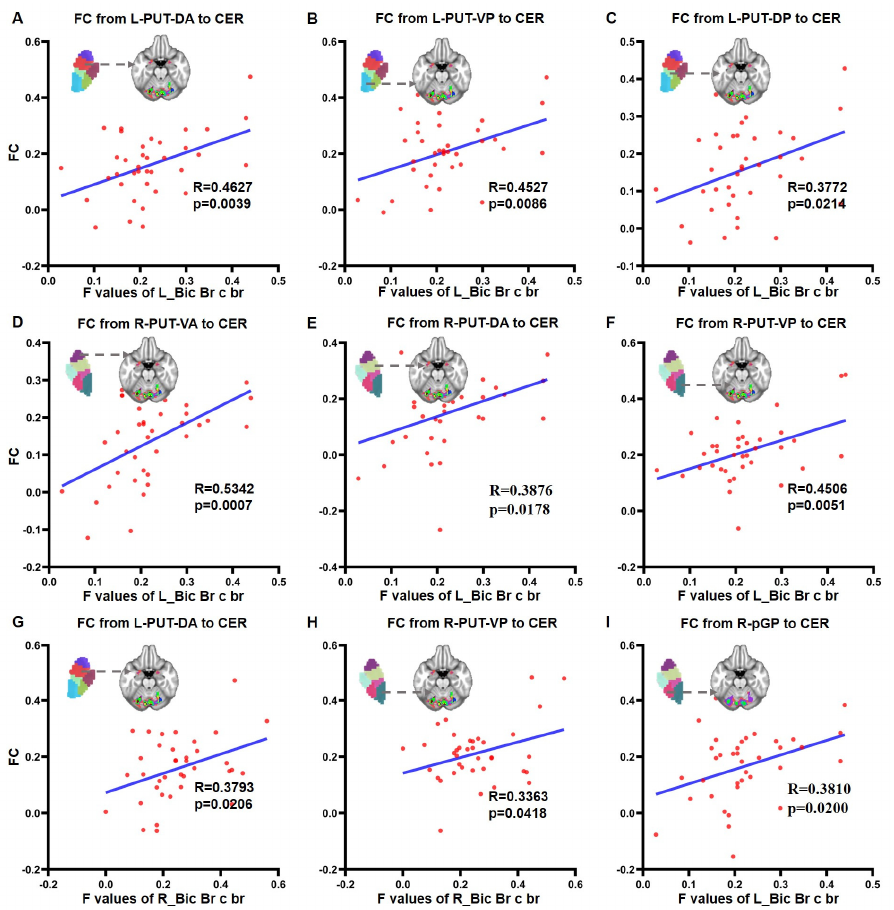
Figure 5. Correlation between FC from the lenticular nucleus to cerebellum and muscle tension level. ( A ) Correlation between FC from L-PUT-DA to CER and F value of L_Bic Br c br; ( B ) correlation between FC from L-PUT-VP to CER and F value of L_Bic Br c br; ( C ) correlation between FC from L-PUT-DP to CER and F value of L_Bic Br c br; ( D ) correlation between FC from R-PUT-VA to CER and F value of L_Bic Br c br; ( E ) correlation between FC from R-PUT-DA to CER and F value of L_Bic Br c br; ( F ) correlation between FC from R-PUT-VP to CER and F value of L_Bic Br c br; ( G ) correlation between FC from L-PUT-DA to CER and R_Bic Br c br; ( H ) correlation between FC from R-PUT-VP to CER and R_Bic Br c br; and ( I ) correlation between FC from R-pGP to CER and L_Bic Br c br; Abbreviations: FC, functional connectivity; CER, cerebellum; MCC, middle cingulate cortex; PUT, putamen; GP, globus pallidus; VA, ventral anterior; DA, dorsal anterior; VP, ventral posterior; DP, dorsal posterior; p, posterior; L, left; R, right; F, frequency of muscle oscillation; L_Bic Br c br, left Biceps Brachii short head; R_Bic Br c br, right Biceps Brachii short head.